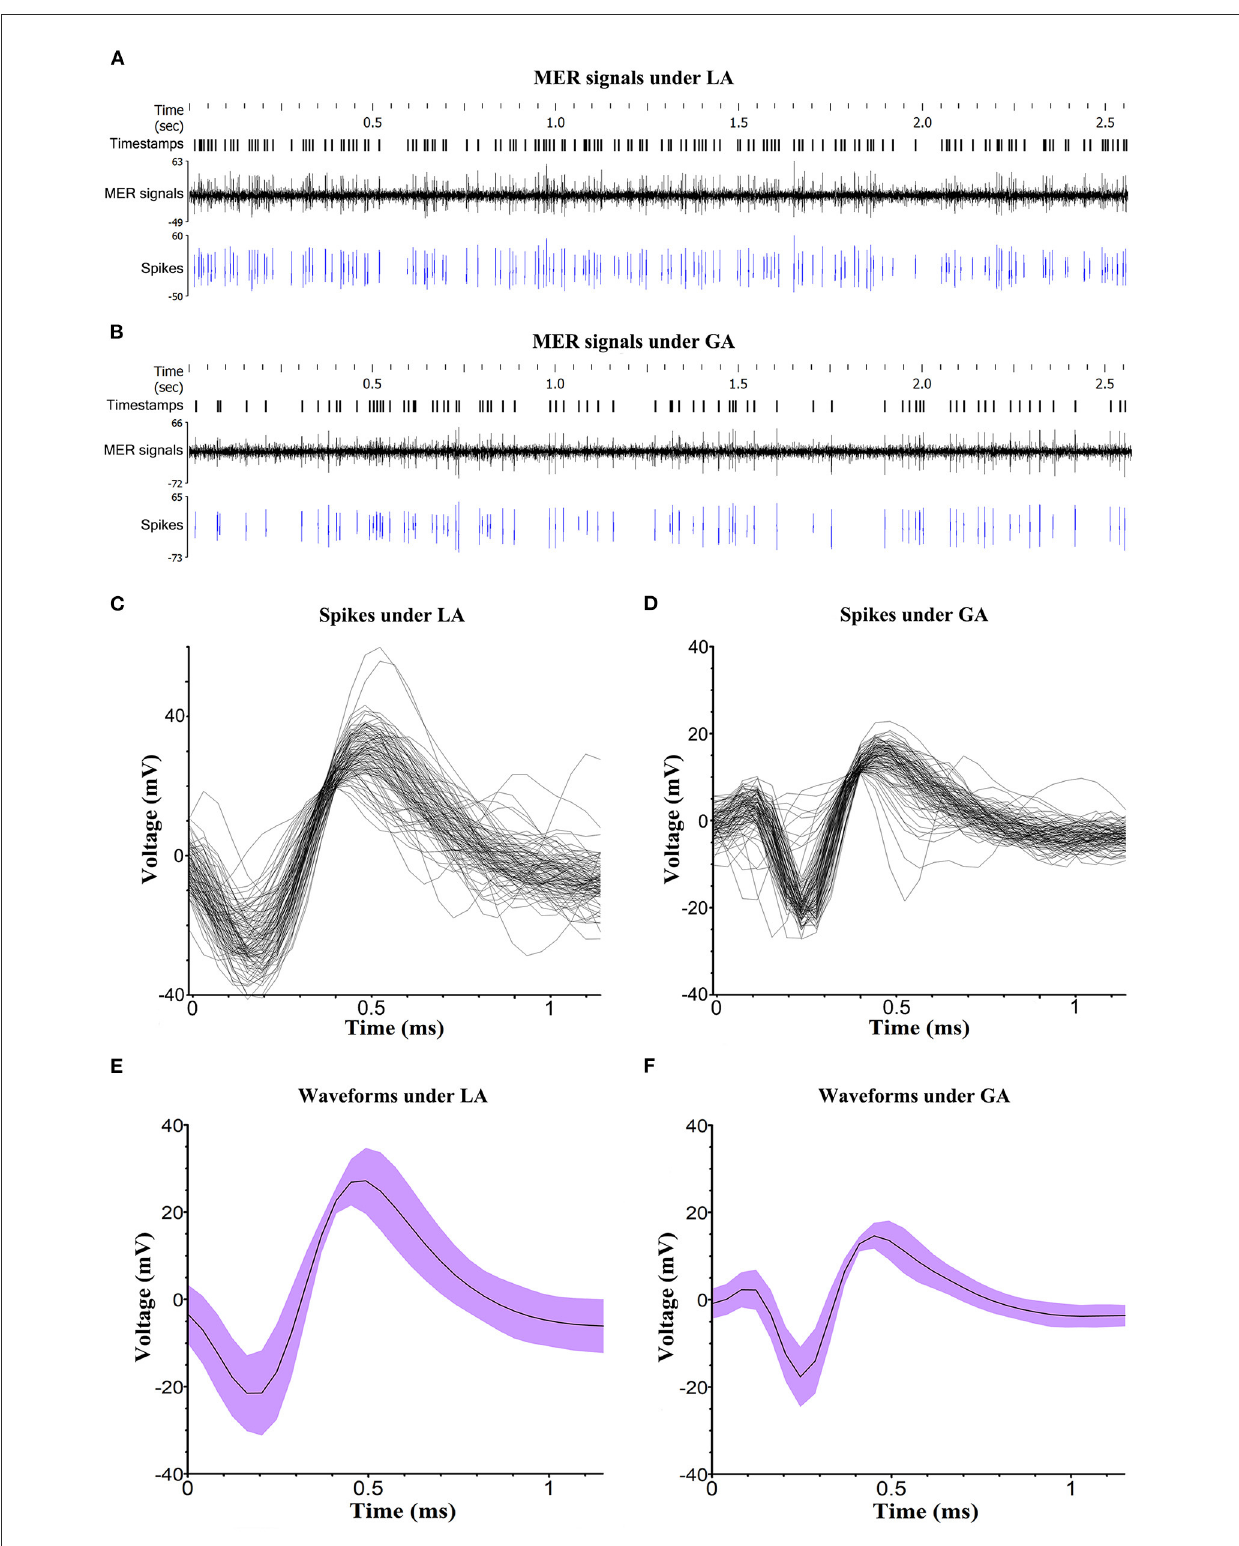
FIGURE2 Analysis of MER signals. (A, B) Typical STN MER signals under LA and GA. The signal activities that were significantly over the baseline amplitude of background noise were selected and presented as spikes. Timestamps marked the specific time of detected spikes. (C, D) The spike sorting for a single unit in LA and GA groups, performed by NeuroExplorer (version 5.311). (E, F) The waveforms of spike under LA and GA. The voltage was displayed as mean value and